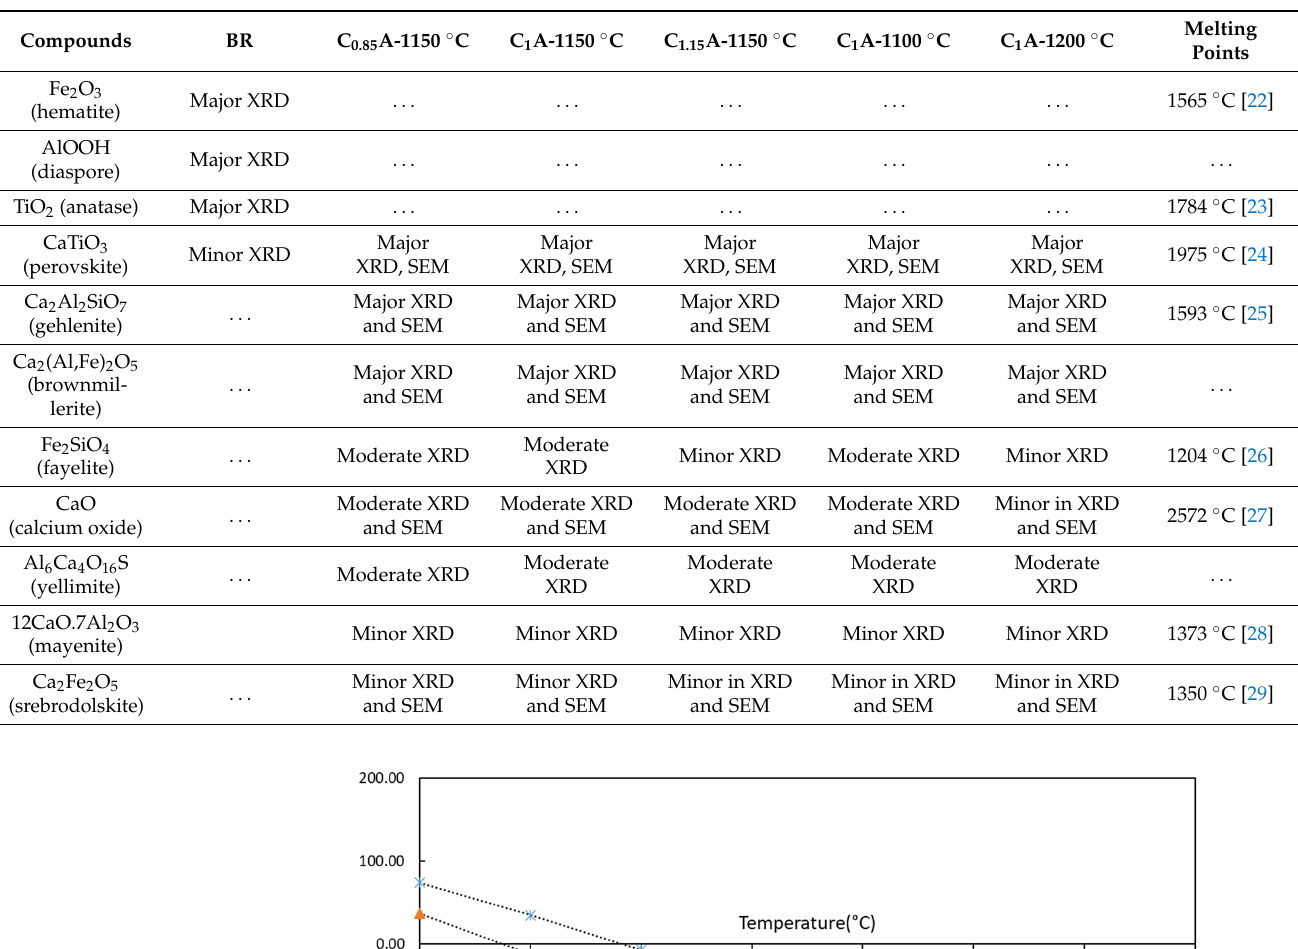
Table 7. The identified phases in the produced pellets at different compositions/temperatures, sorted based on their XRD spectrum intensity and SEM image analysis.